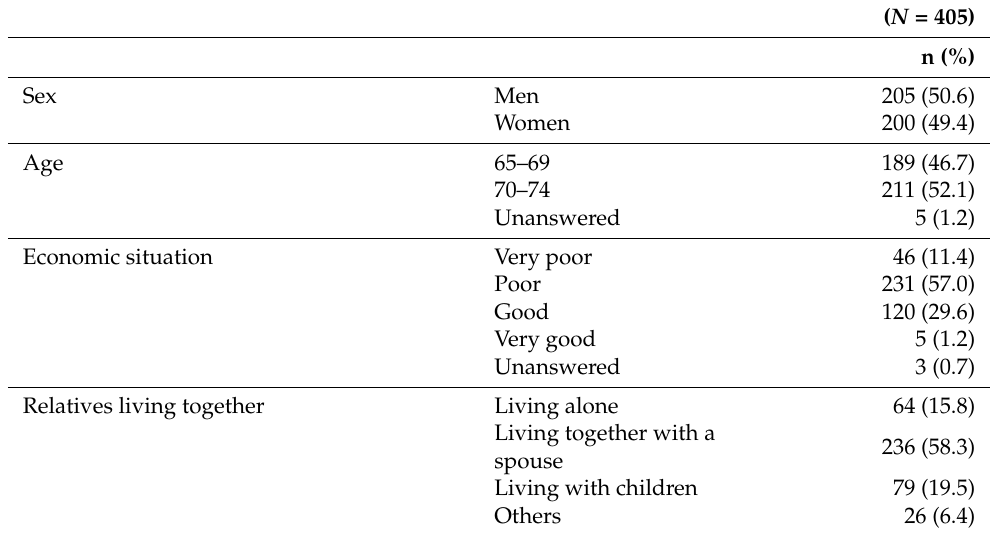
Figure 1. Conceptual framework. Table 1. Characteristics of the